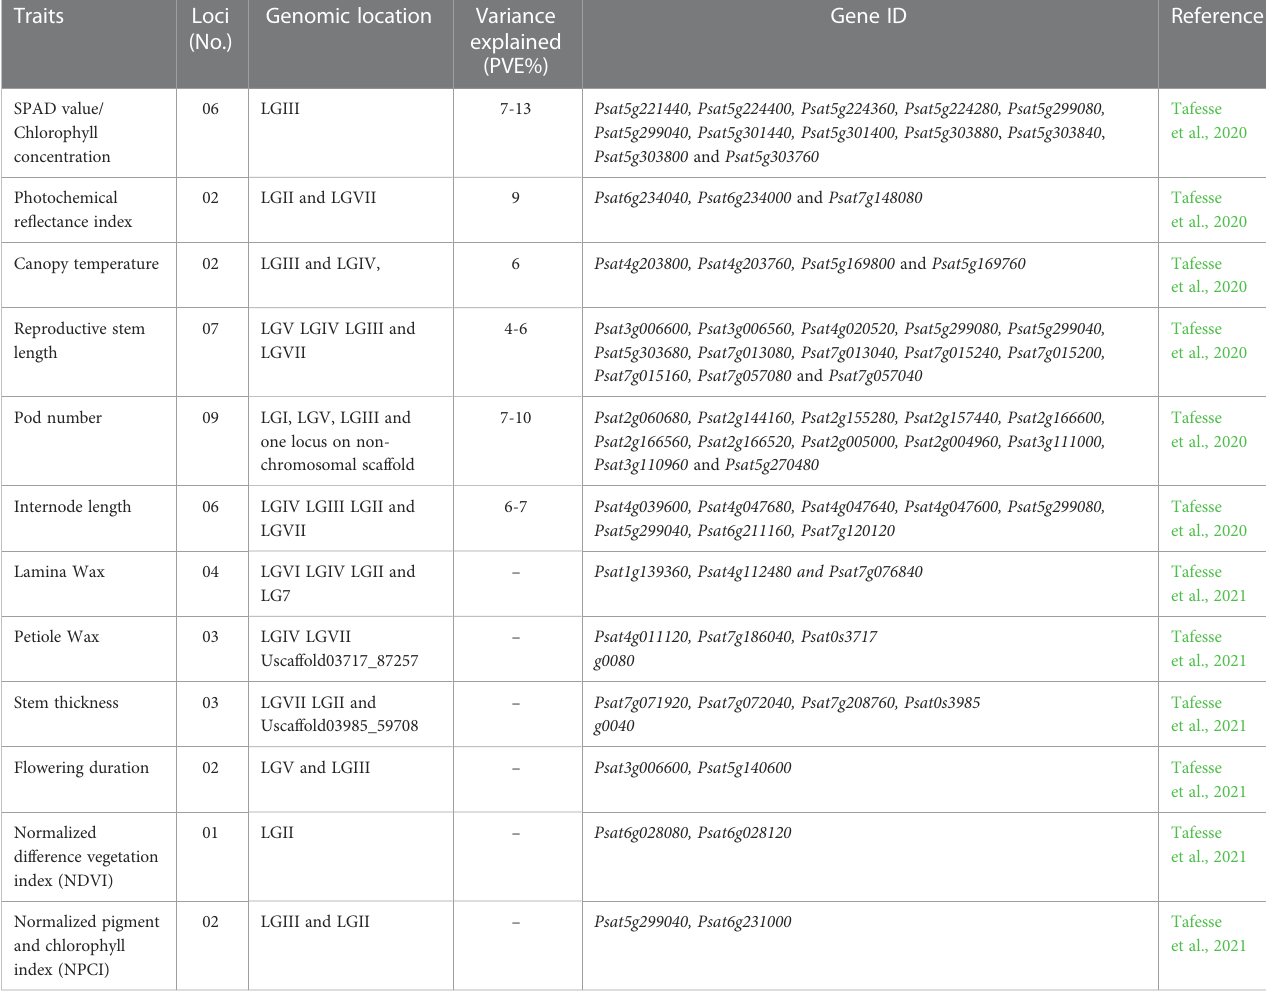
TABLE 3 QTLs discovery of heat responsive traits with their genomic locations and candidate genes in Pisum .